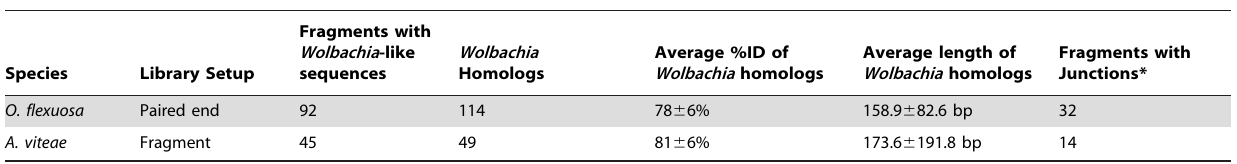
Table 1. Identification of Wolbachia -like